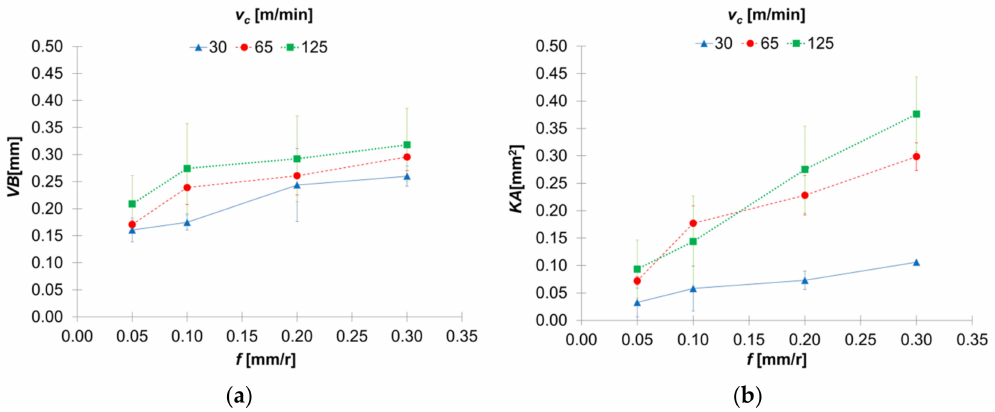
Figure 6. Tool wear intensity evolution as a function of v c and f . ( a ) Flank wear ( VB ); ( b ) crater wear ( KA